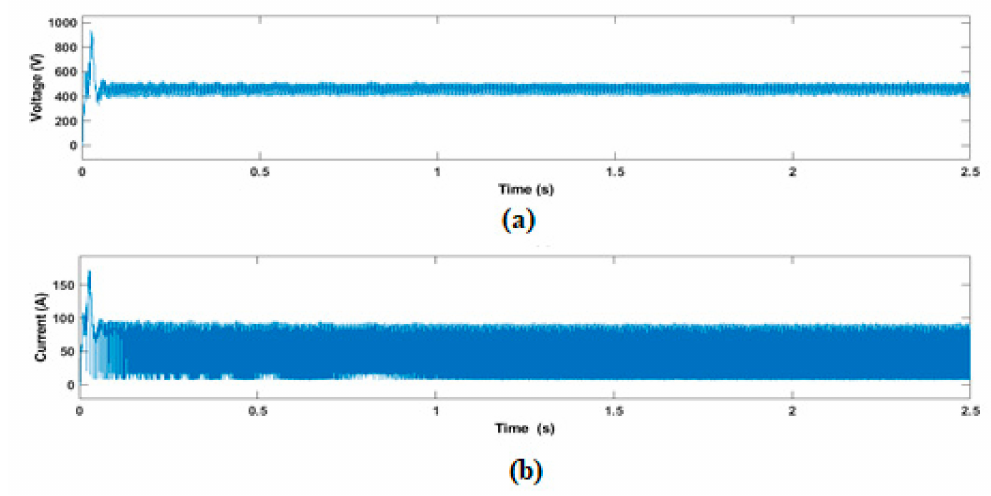
Figure 20. Boost converter outputs of ( a ) voltage and ( b ) current during Scenario 1.